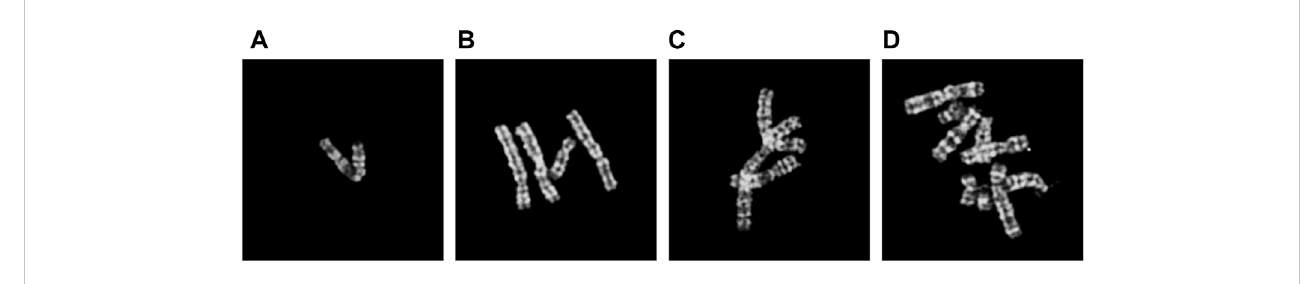
FIGURE 1 Examples of different types of chromosome clusters include (A) instance, (B) touching, (C) overlapping, and (D)